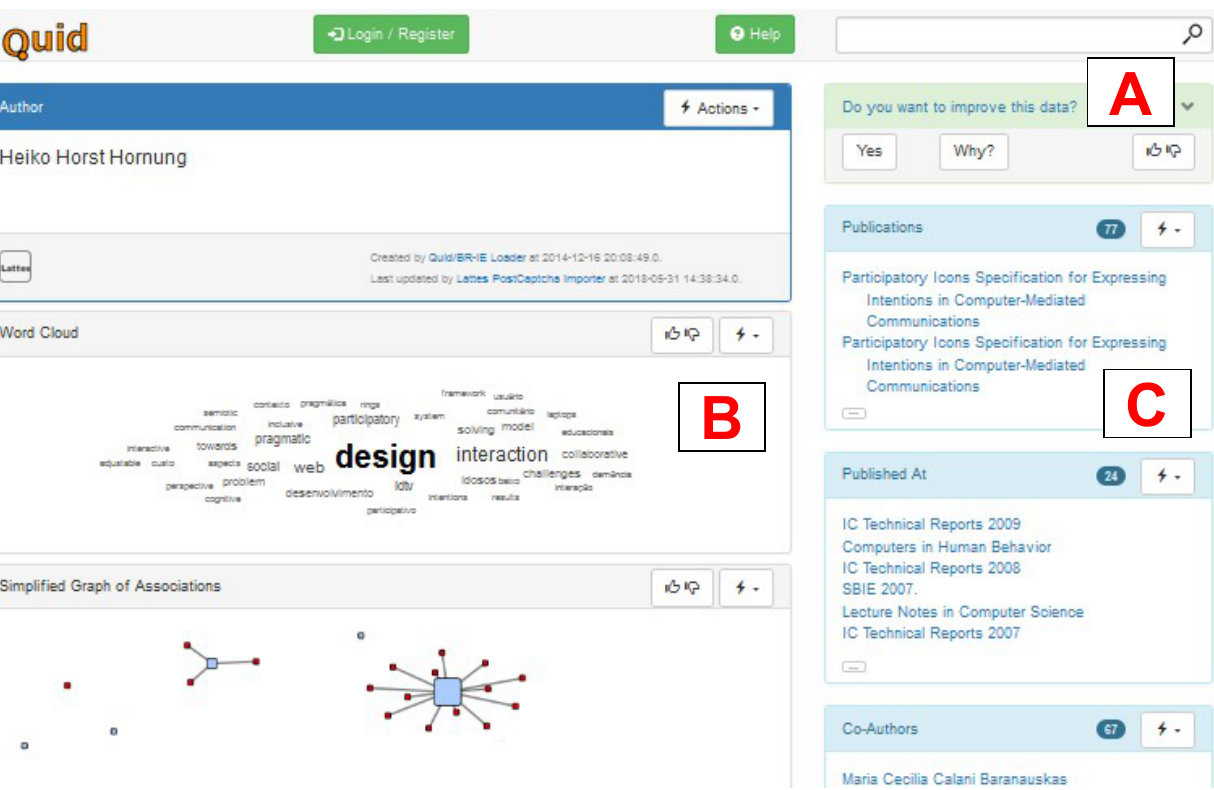
Fig. 24. Snapshot of Quid user interface. Details: (A) feature inviting users to help in update their data; (B) “word cloud” and (C) “publication list” – both can can be dinamically embedded in any other external web page using